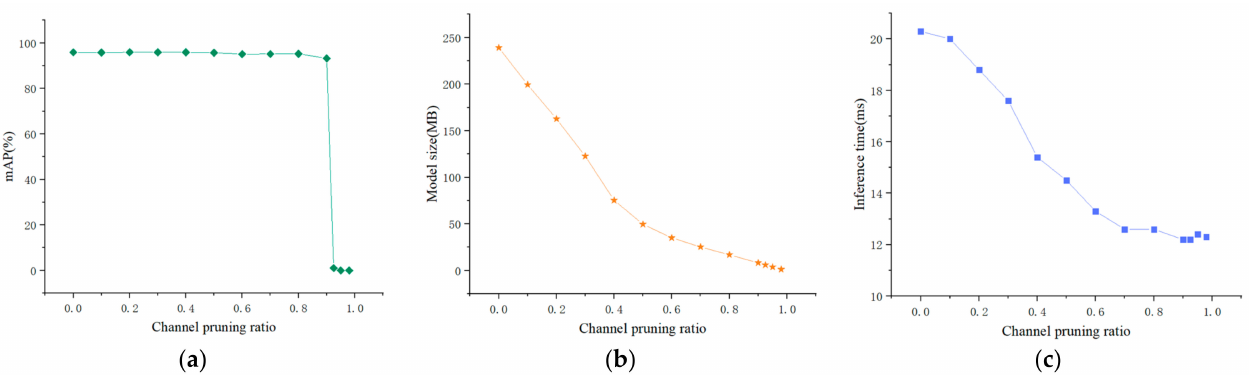
Figure 8. The value of the mAP score, model size, and inference time under different channel pruning rates. ( a ) Model mAP curve. ( b ) Dimension size curve. ( c ) Inference time